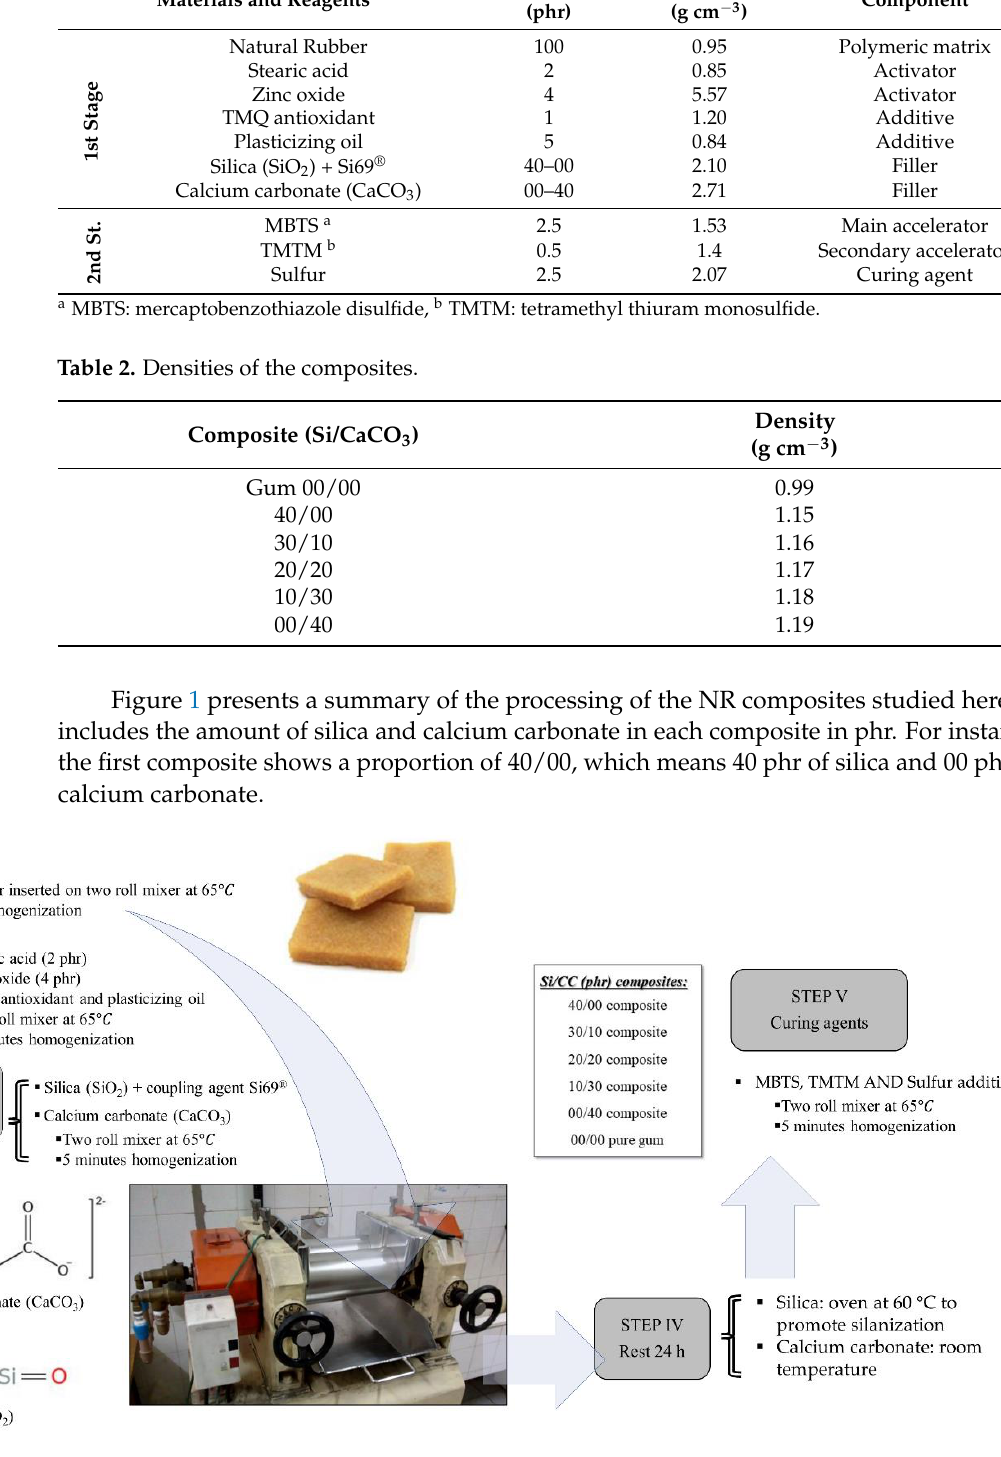
Figure 1. Natural rubber processing: from latex to vulcanization.